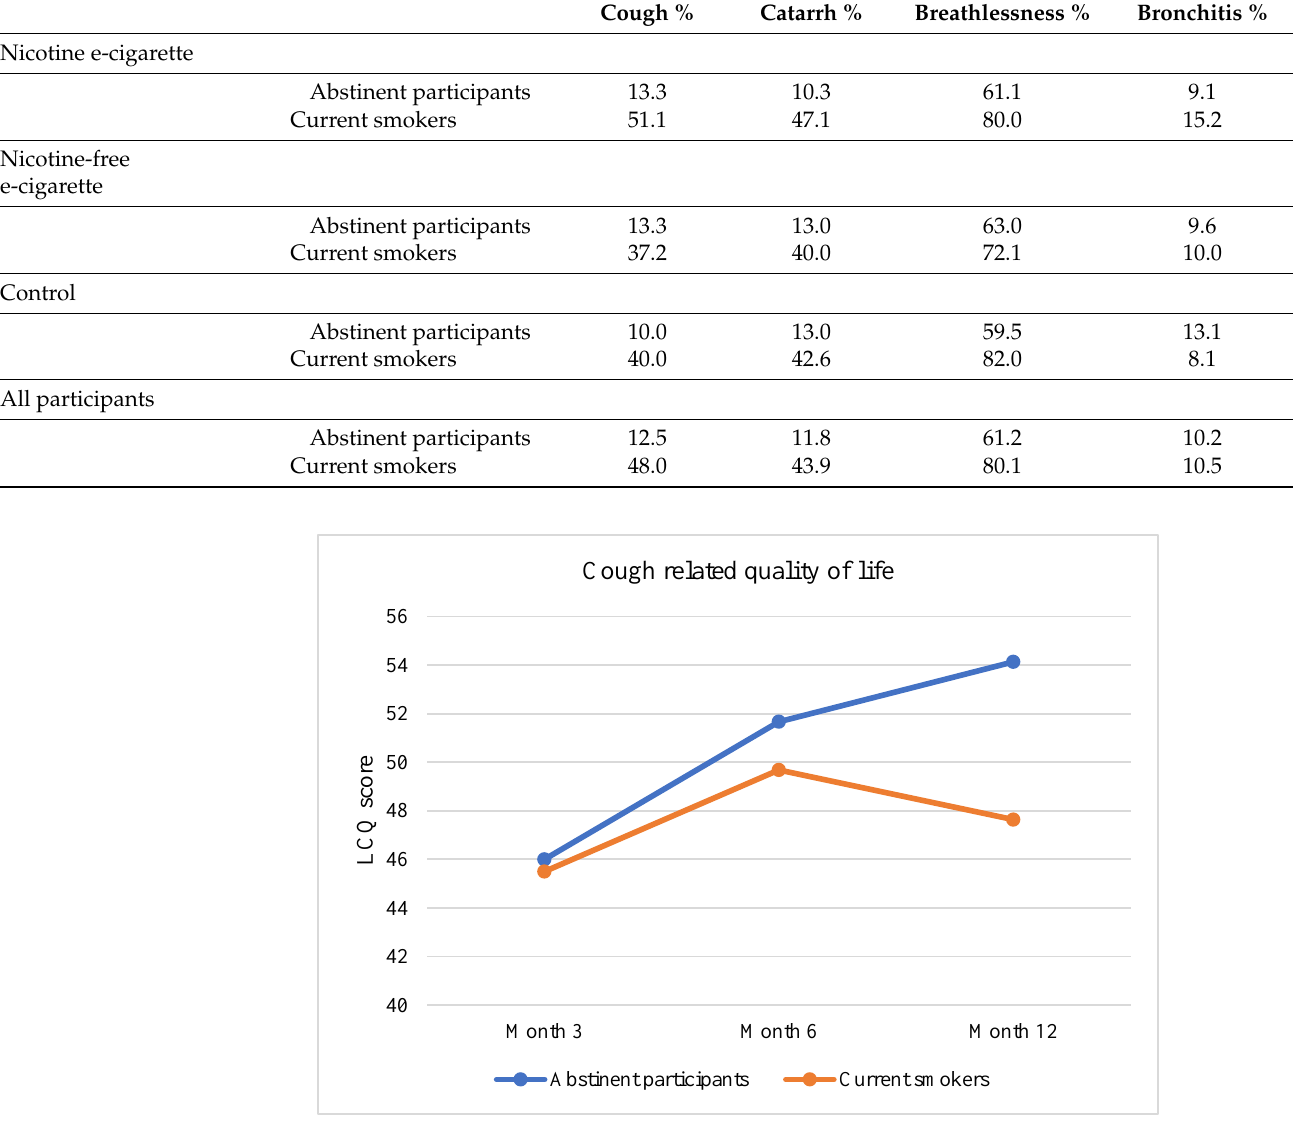
Figure 2. Change in Cough related quality of life as measured by LCQ throughout the study